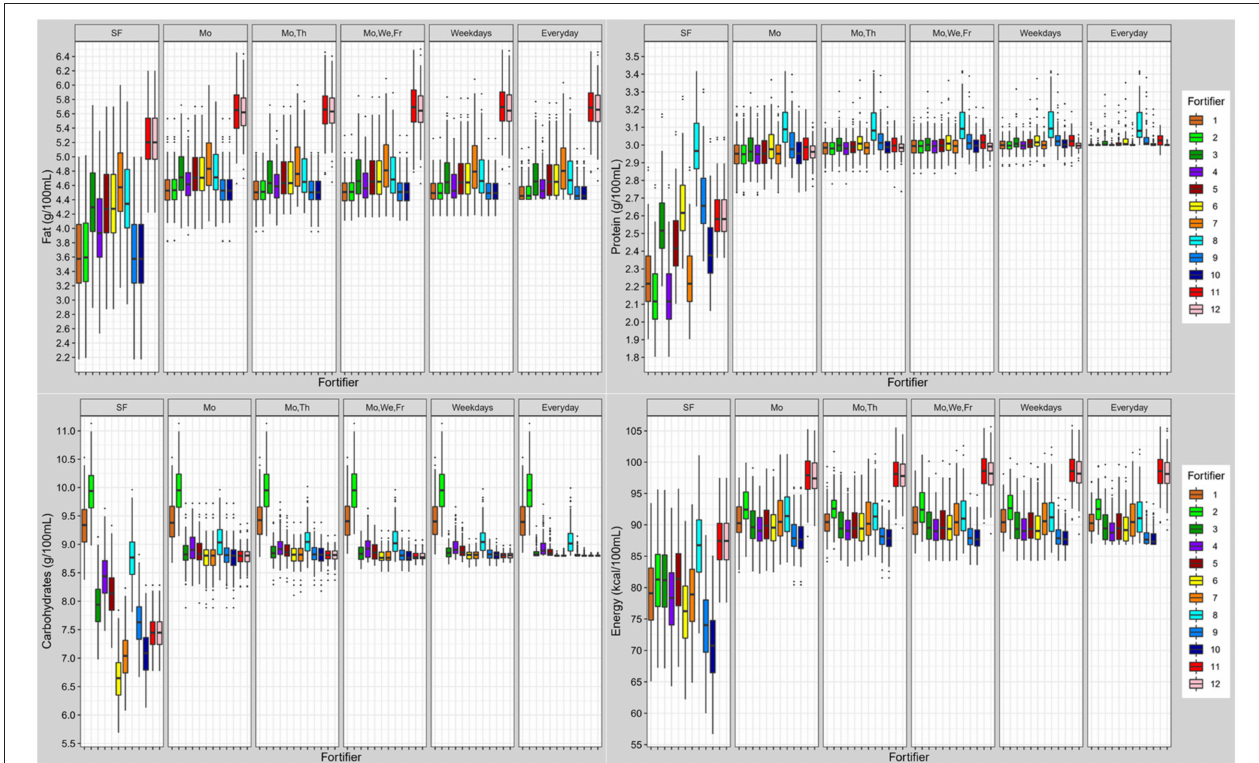
FIGURE 6 | Macronutrient (fat, protein, carbohydrates) and energy content of fortified breast milk with 12 fortifiers using different schedules for milk analysis. Boxplots display the distribution of the mean intake of n = 103 subjects. Dots represent outliers (SF, standard fortification; Mo, Monday; We, Wednesday; Th, Thursday; Fr, Friday; SF, fortifier 11 and 12 are identical due to following standard fortification